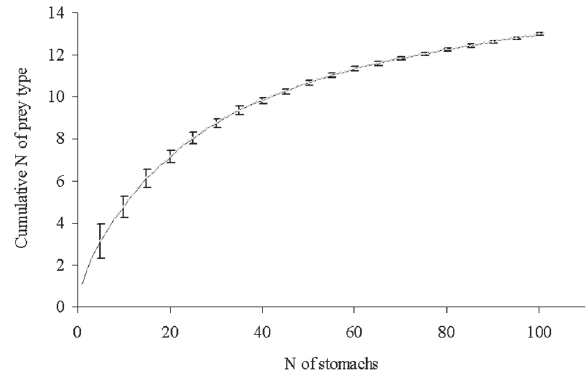
Fig . 3. – prey species accumulation plot as an average of 999 curves based on different random orders of the stomachs extracted (n. of stomachs = 101). Vertical bars represent standard deviation.